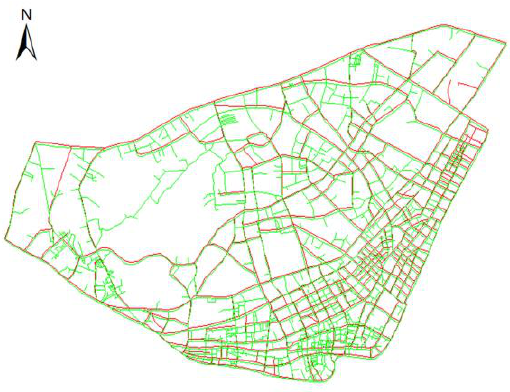
Figure 13. Same-scale road network pairs from Wuhan City (Area 1).